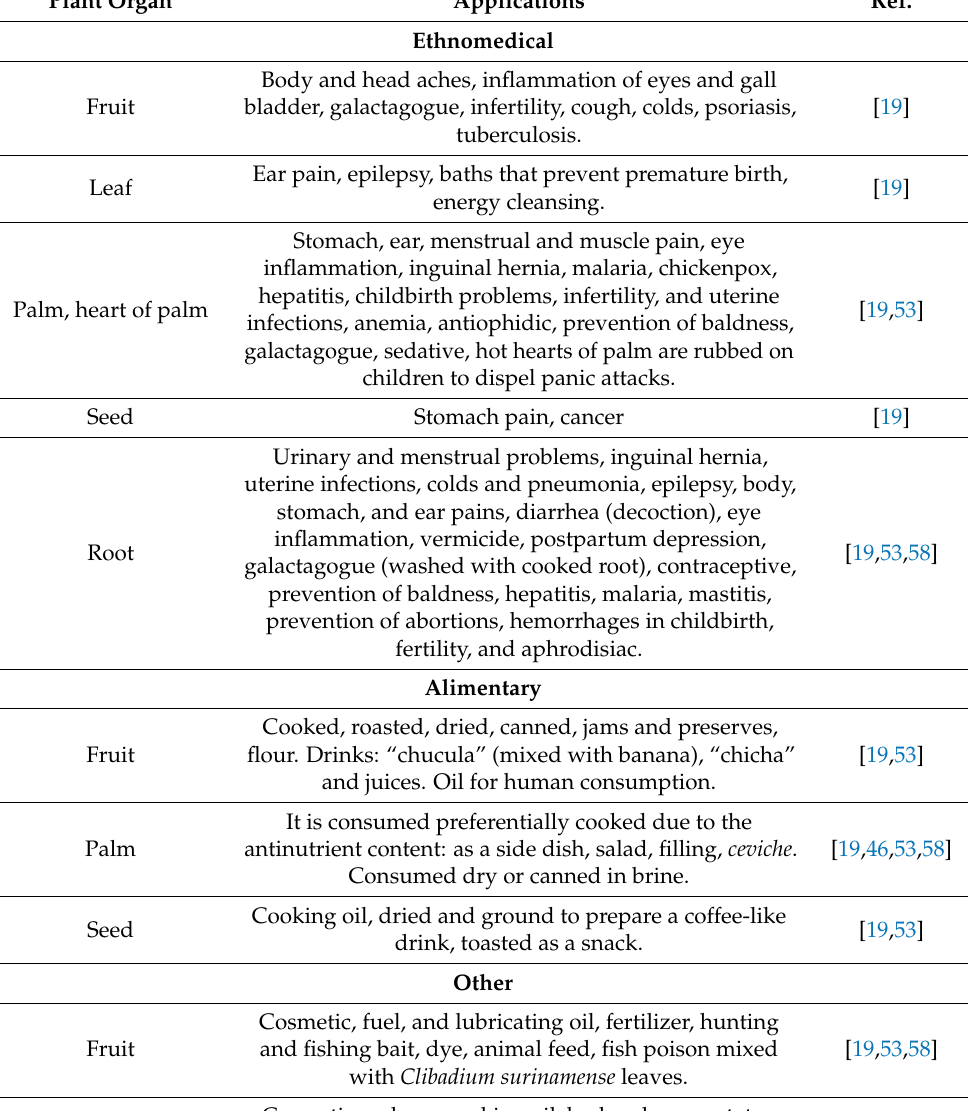
Table 2. Traditional uses of B. gasipaes ordered by plant organs. Plant